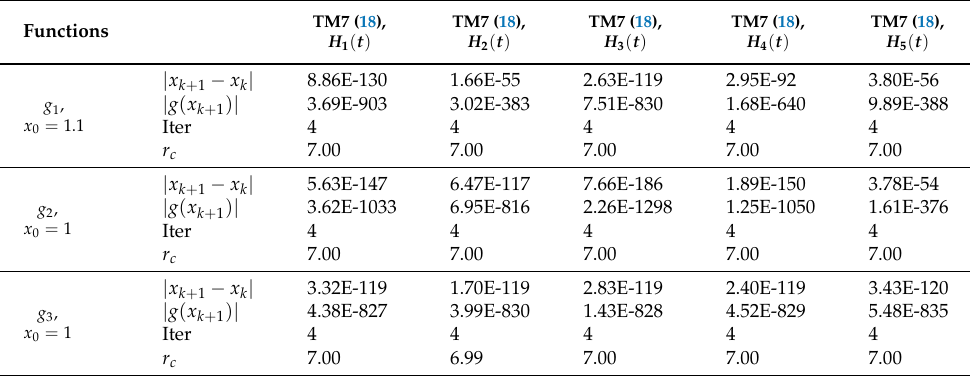
Table 4. Comparison of various iterative schemes (fourth